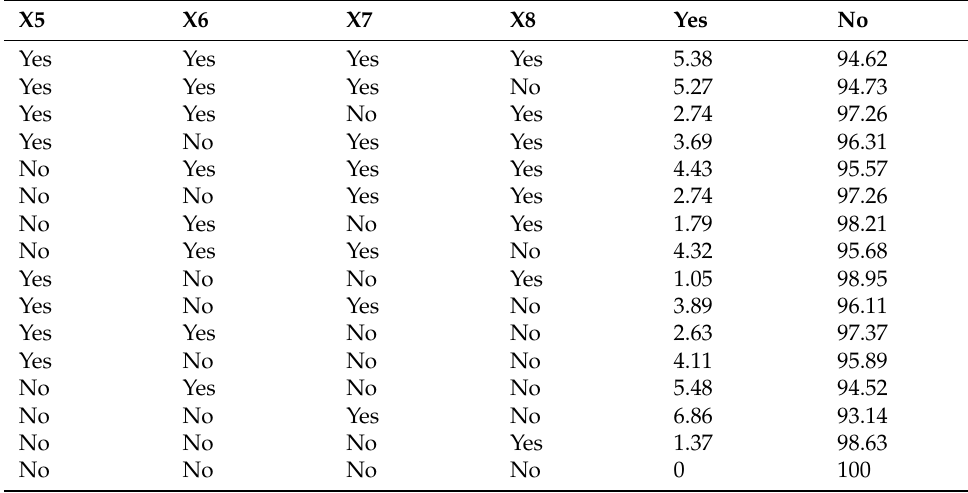
Table A5. Conditional probability of node